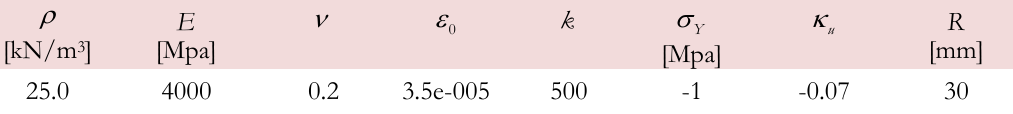
Table 3: Material parameters adopted in the numerical